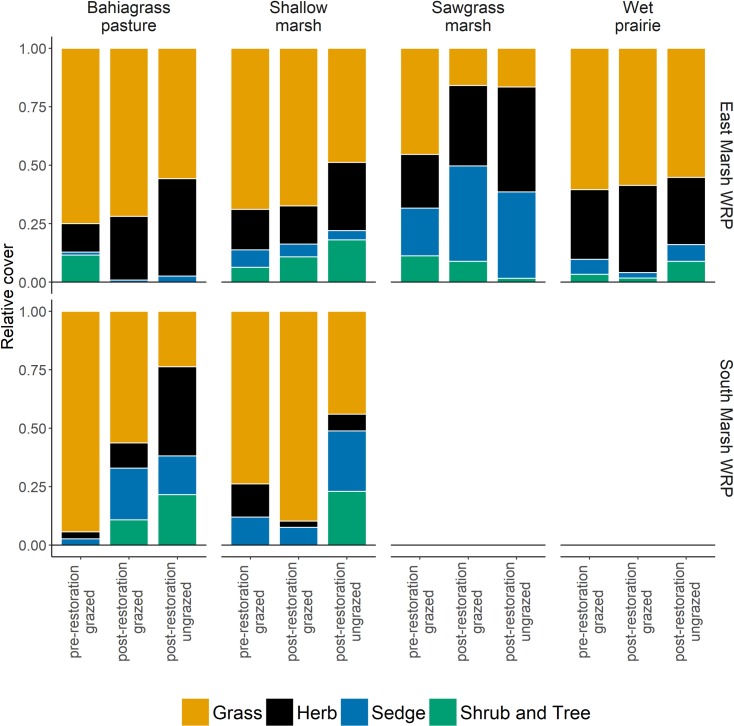
Average relative cover of each life form prior and following restoration and in response to removal of grazing.Before restoration all 300 plots were grazed. We used a subset of the grazed plots for this analysis (see details in material and methods).